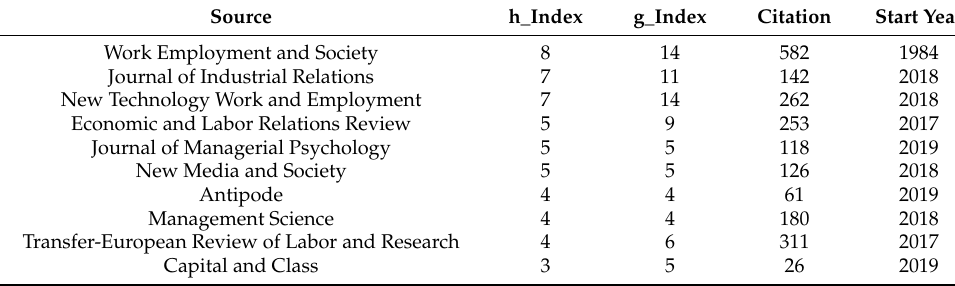
Table 3. Journal classification is based on their impact.